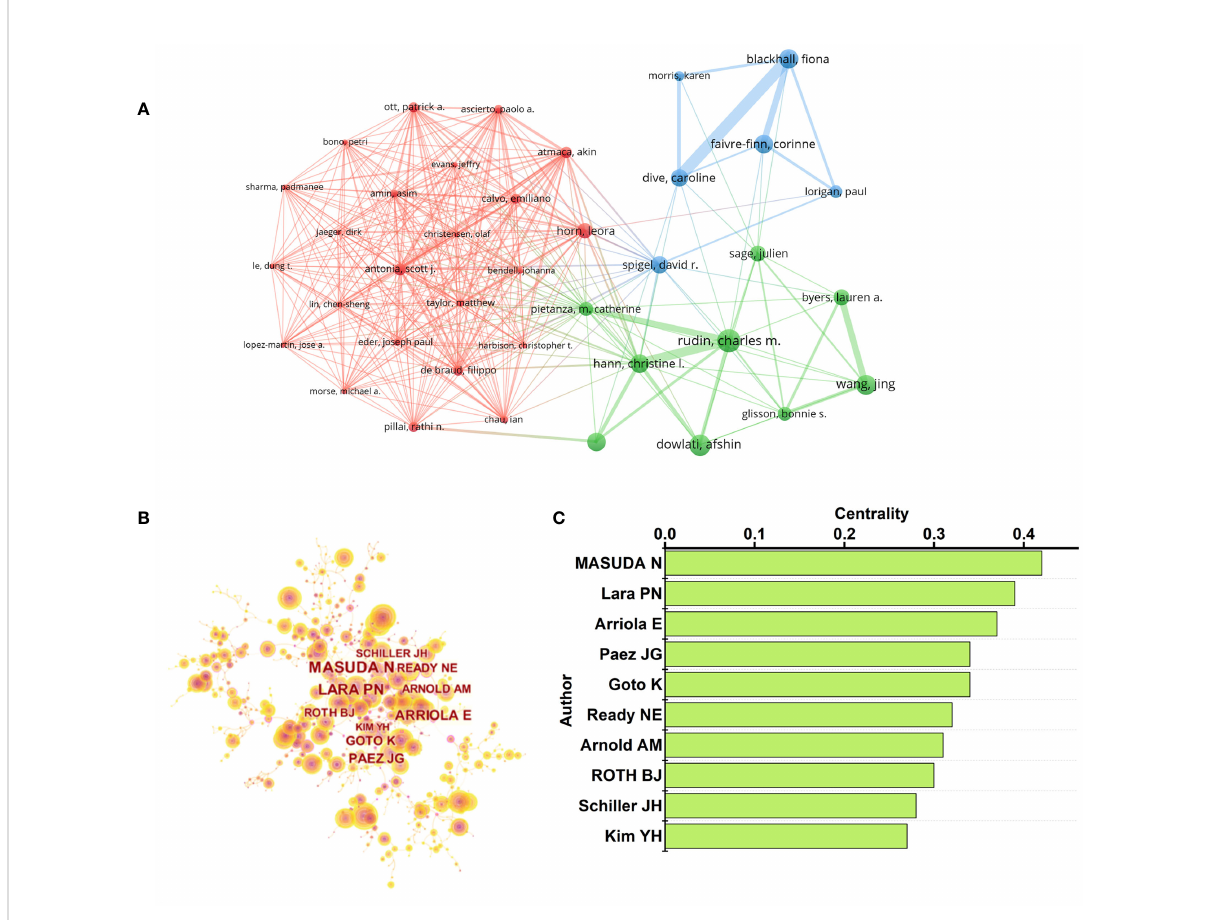
FIGURE 7 (A) Co-authorship relationships between authors. Top3 TLS was: Antonia, Scott J. (TLS=42), Atmaca, Akin (TLS=42), and Hann, Christine L (TLS=40). (B) Co-Citation relationships between authors. (C) The top 10 authors of centrality in Figure 7B.